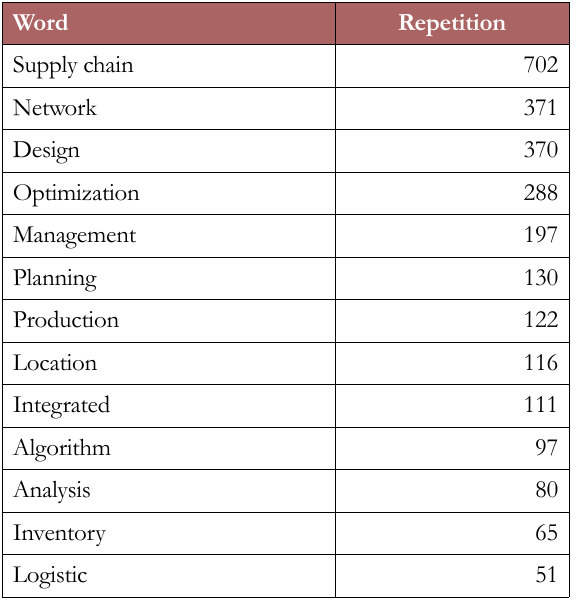
Table 7. The most common words in title of articles Table 8. The most common words in keywords of